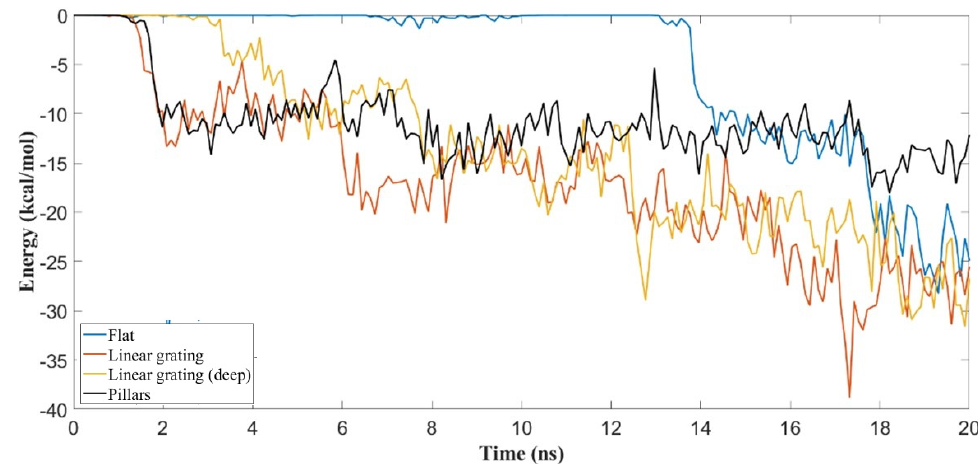
Figure 3. Van der Waals (VdW) and electrostatic (el) energies for different nanoscale topographies. For shallow linear grating (SLG) and pillar (PLR) substrates, adsorption occurred within less than 2 ns, while for deep linear grating (DLG), it occurred after 3 ns. Simulation